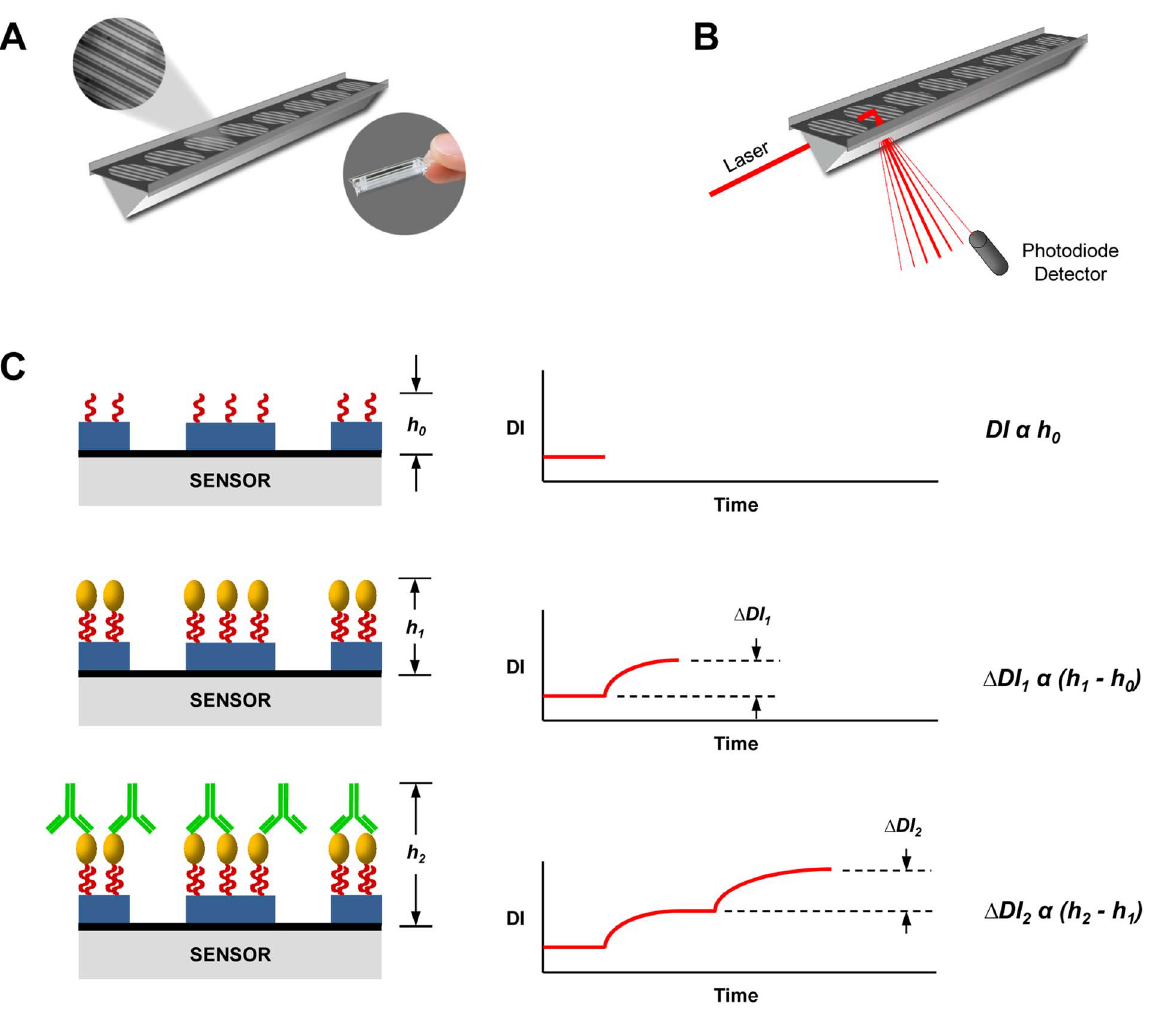
Figure 1. Schematic representation of a dotLab biosensor. (A) Each sensor consists of a contiguous array of 8 assay locations spotted on the bottom of a 10 m L flow channel where reagents and samples are introduced. Each assay location is comprised of a repeating pattern of capture molecules arranged in a defined series of parallel lines creating a diffraction grating. (B) Illumination of an assay spot with a laser generates a predictable diffraction image. The intensity of the diffraction image is monitored in real time by a photodiode detector. (C) Increases in the height ( h ) of the diffraction grating due to molecular binding events results in a proportionate increase in the diffraction image intensity ( D DI ).